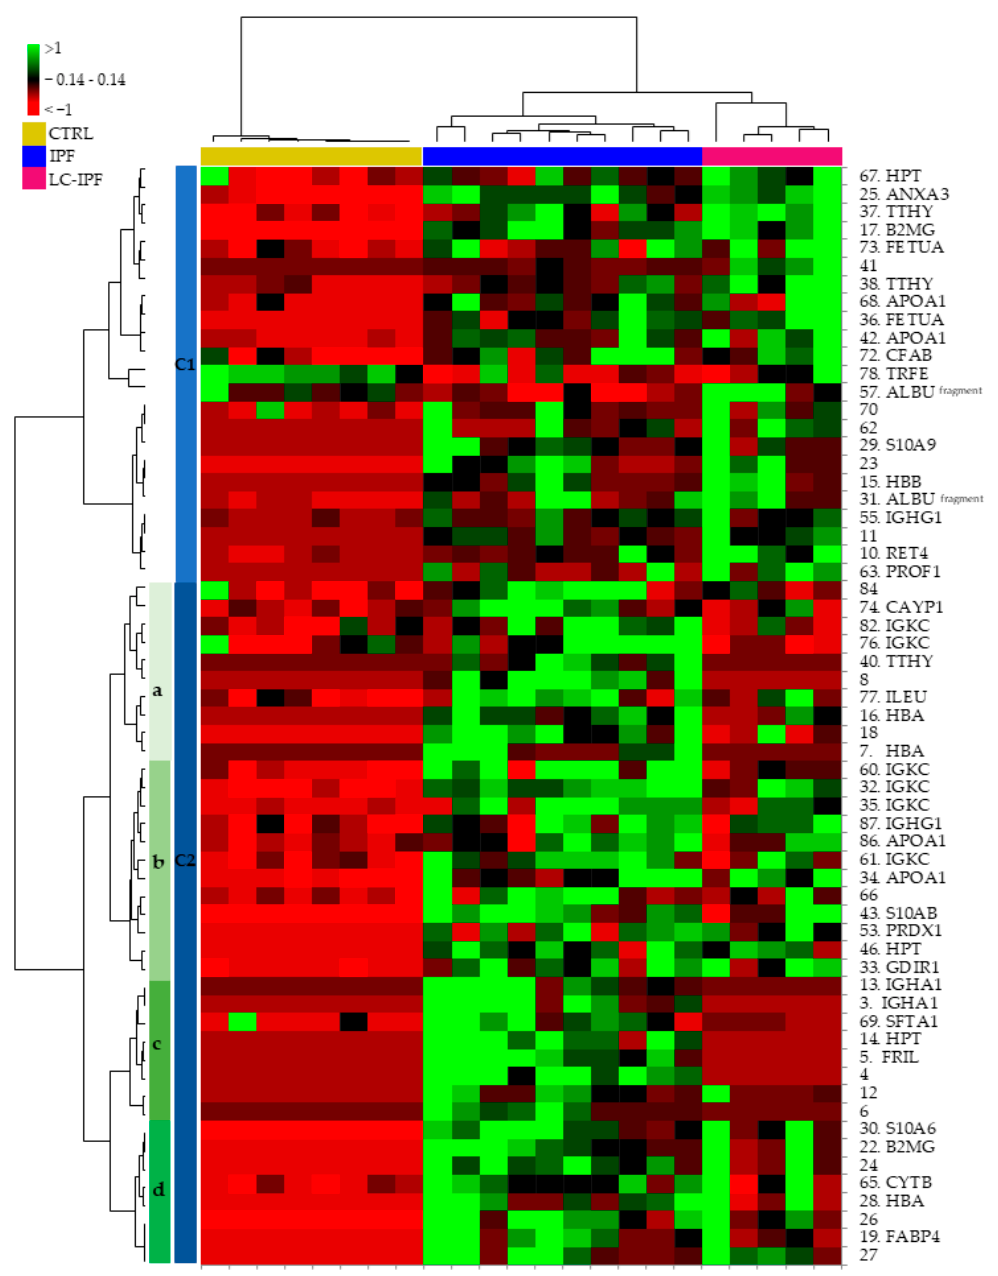
Figure 2. Supervised heatmap analysis by XLSTAT performed using the statistically valid DASs, detected by proteomic analysis of BALF samples.